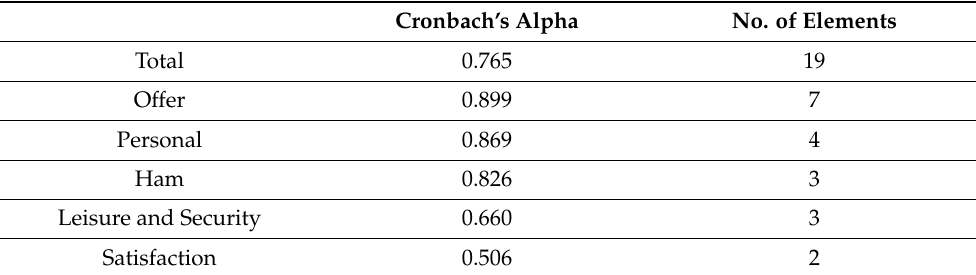
Table 8. Reliability